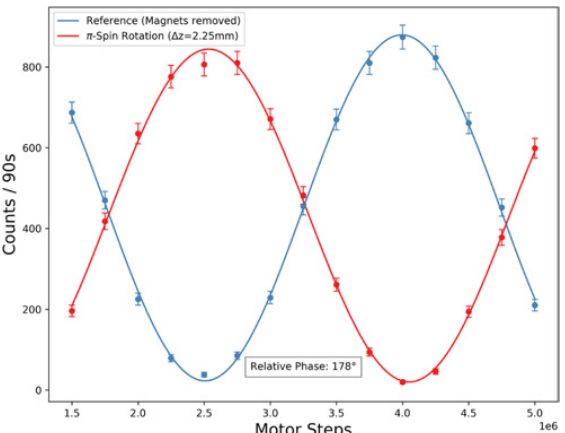
Figure 9. Contrast of interferograms for different magnetic field strengths (varied via (cid:5) z ). The contrast vanishes for values of (cid:5) z corresponding to values of the rotation angle α = (2 n + 1) π